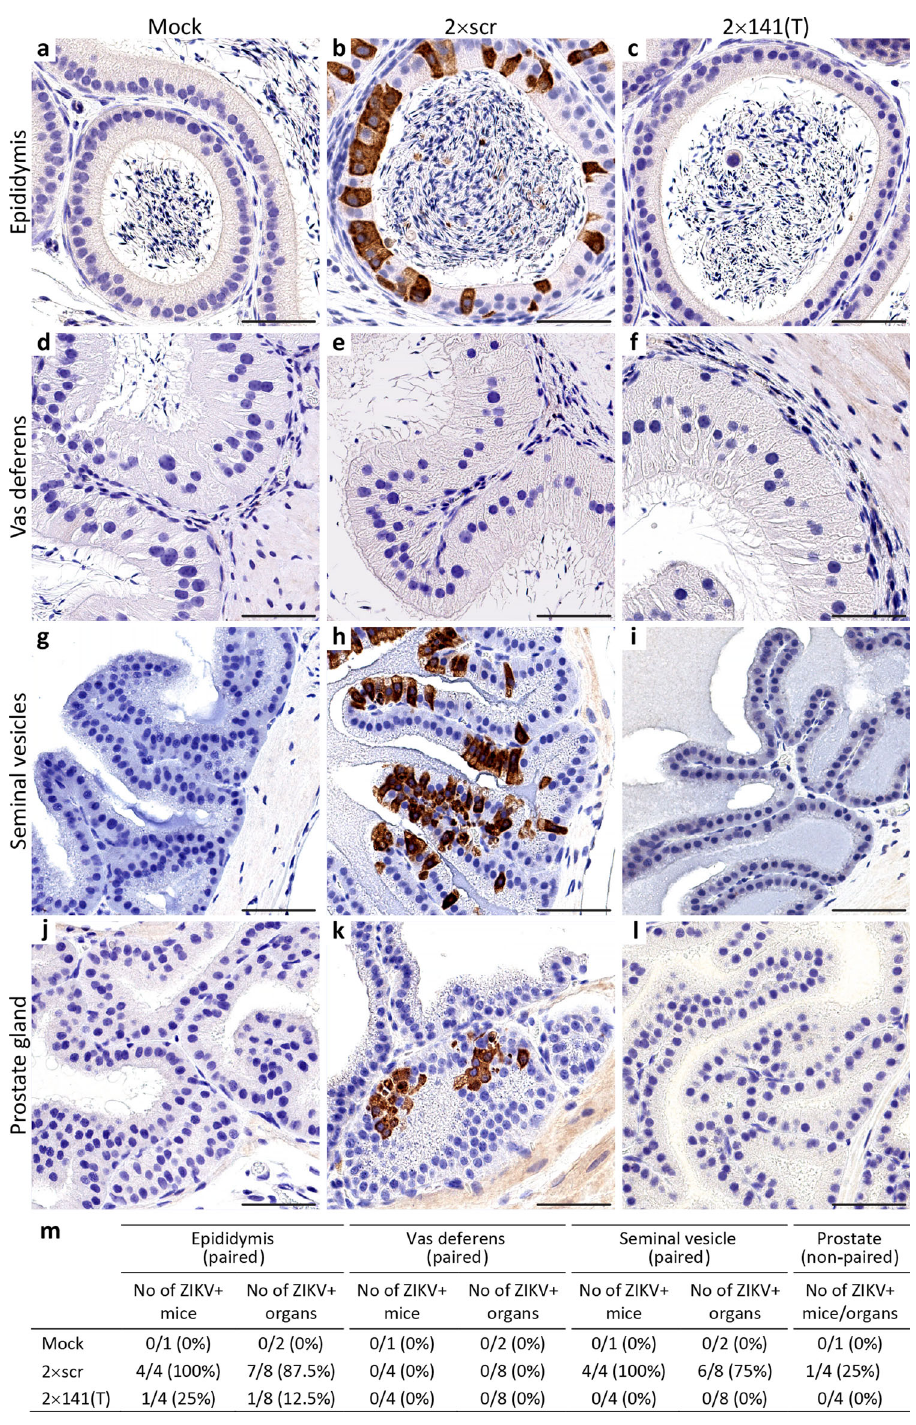
Fig. 2 Genome targeting for mir-141 restricts ZIKV ability to infect epithelial cells of epididymis, seminal vesicles, and prostate. Adult AG129 mice were mock- inoculated ( a , d , g , j ; n = 1) or infected IP with 10 6 pfu of 2×scr ( b , e , h , k ; n = 4) or 2×141(T) ( c , f , i , l ; n = 4) virus. Representative images of immunoreactivity (IR) for ZIKV antigen in the epididymis ( a – c ), vas deferens ( d – f ), seminal vesicles ( g – i ), and prostate ( j – l ) at 9dpi (experiment was performed once). Scale bars: 50 µ m. m Summary of ZIKV-IR detection in the MRS of mice infected with 2×scr or 2×141(T) viruses as compared to mock. A paired mouse organs (epididymis, vas deferens, and seminal vesicles) were considered ZIKV positive (ZIKV + mouse), if ZIKV + cells were detected either unilaterally or